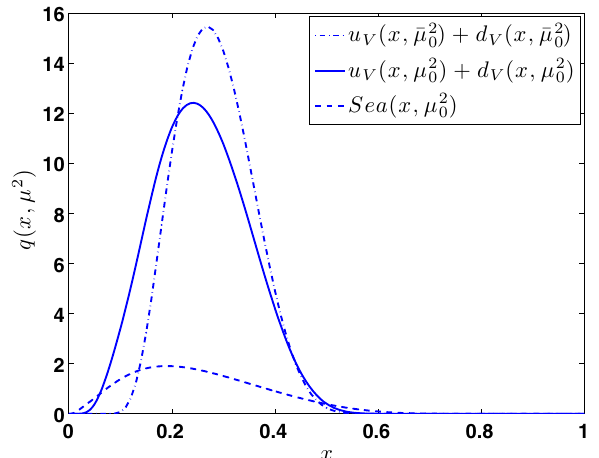
Fig. 7 The parton distributions at the scale μ 2 of the physical nucleon. 0 The total non-perturbative sea due to Meson–Baryon fluctuations con- tains both strange and non-strange components (dashed line). The valence distribution (continuous line) is consistently renormalized (cf. Eqs. (30), (31)). For comparison also the valence distribution of the bare nucleon is shown (dot-dashed